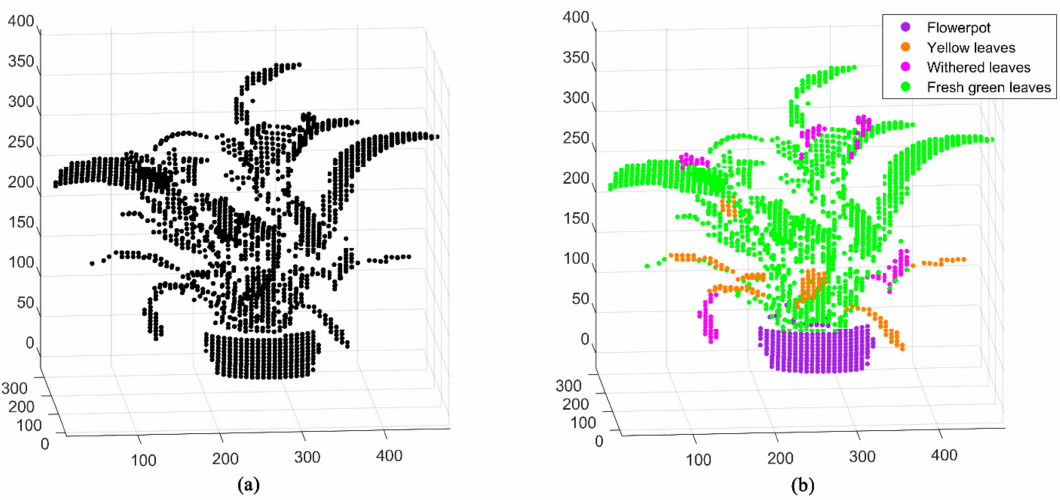
Figure 6. Scene 2 scanning experiment 3D point cloud based on MWFL system. ( a ) Three-dimensional distribution of spatial point cloud; ( b ) The ground truth categories given for